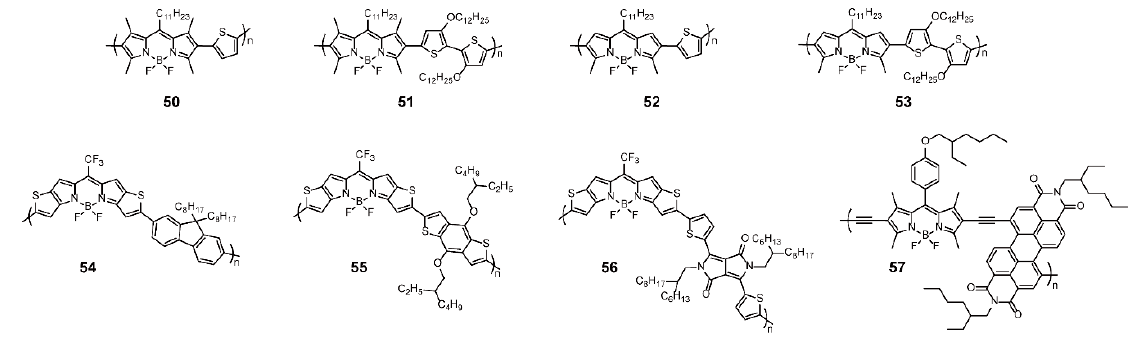
Figure 16. Chemical structures of polymers 50 – 57 (Reproduced with permission from Reference [82]. Copyright @2013 WILEY-VCH Verlag GmbH & Co. KGaA, Weinheim. Reproduced with permission from Reference [83]. Copyright @ 2020, American Chemical Society. Reproduced with permission from Reference [84]. Copyright @ 2011, American Chemical Society).